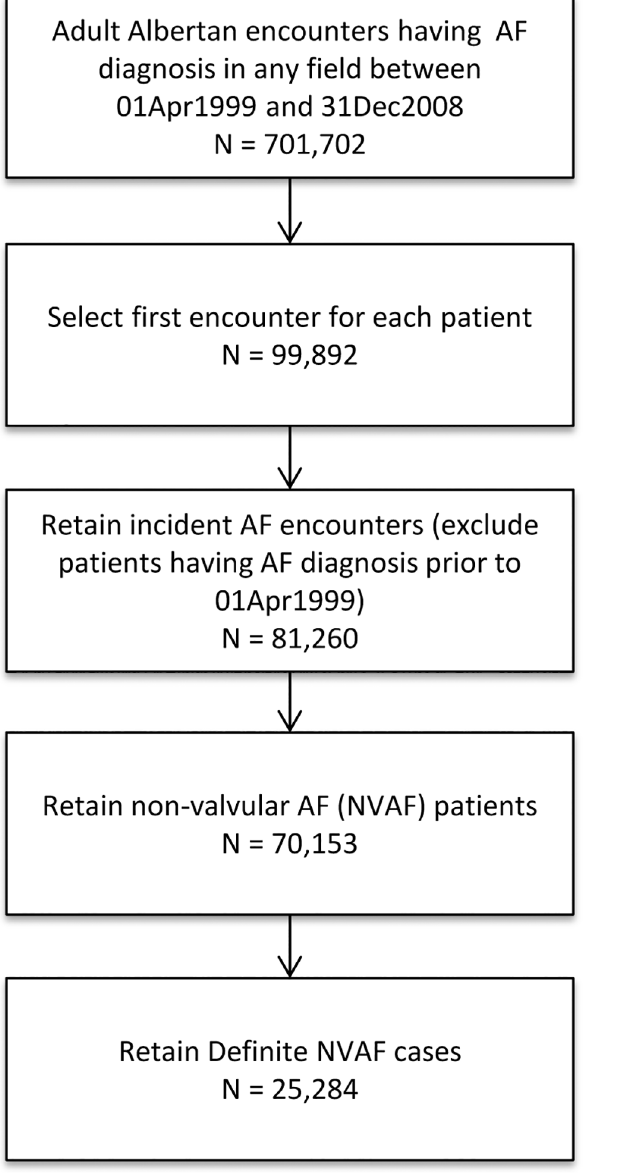
Fig 1. Derivation of